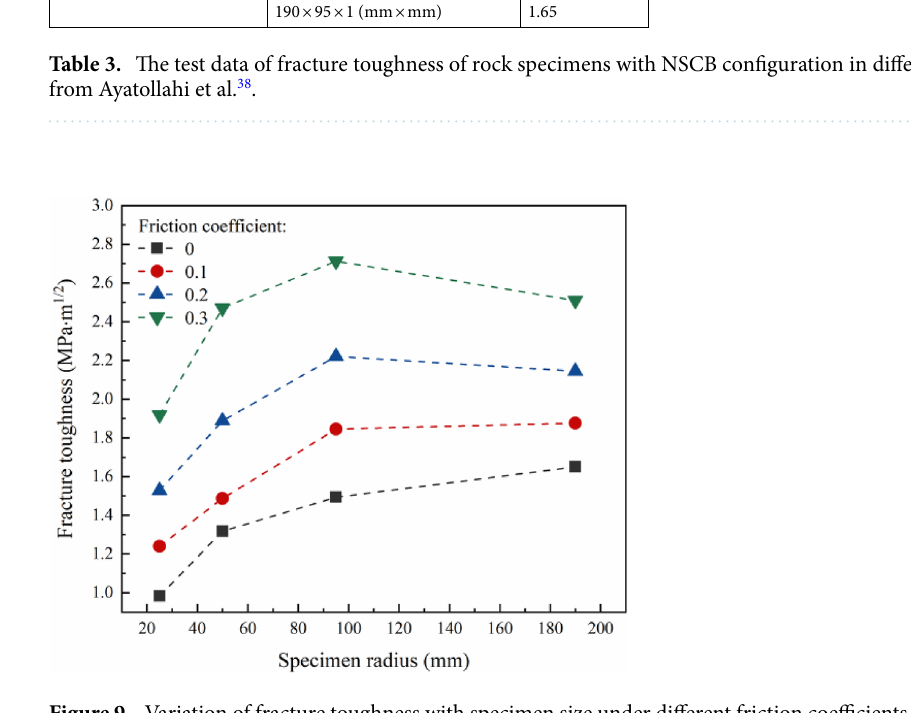
NSCB ( a / R = 0.5, S / R = 0.5)